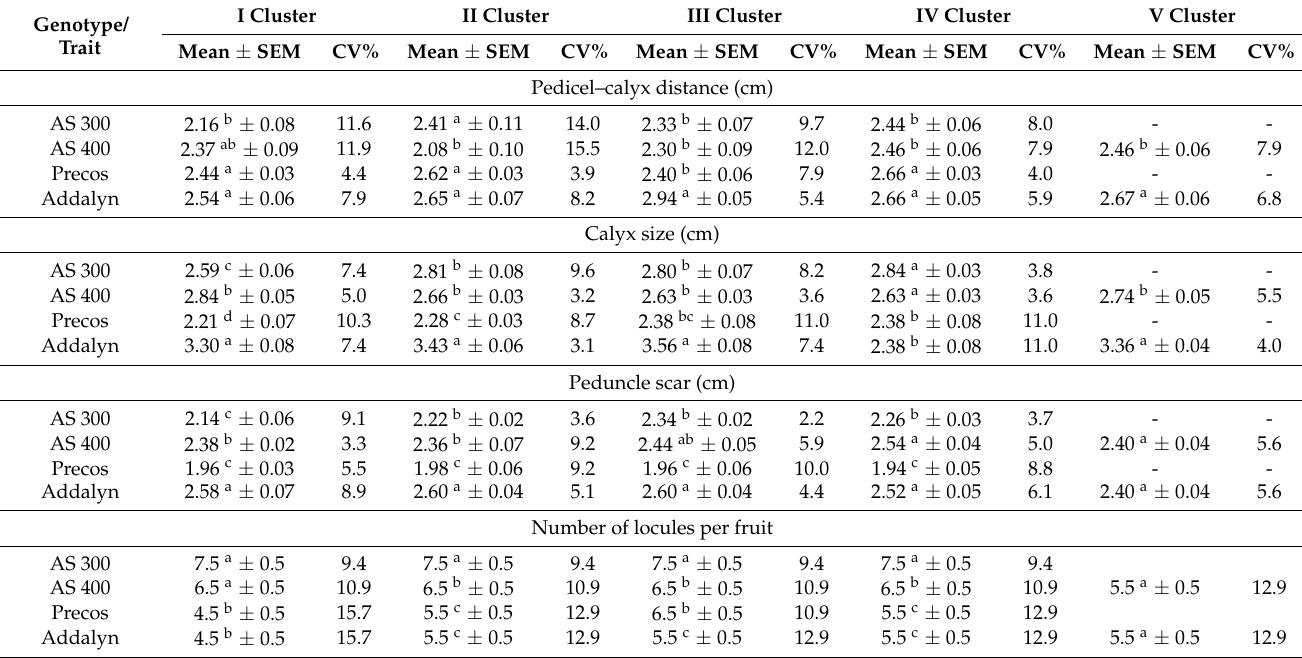
Table 3. External quality parameters of the tomato genotypes, depending on the positions of the fruits on the levels of clusters (I–V): pedicel–calyx distance (cm); calyx size (cm); peduncle scar (cm); and internal parameter, respectively, locules/fruit.